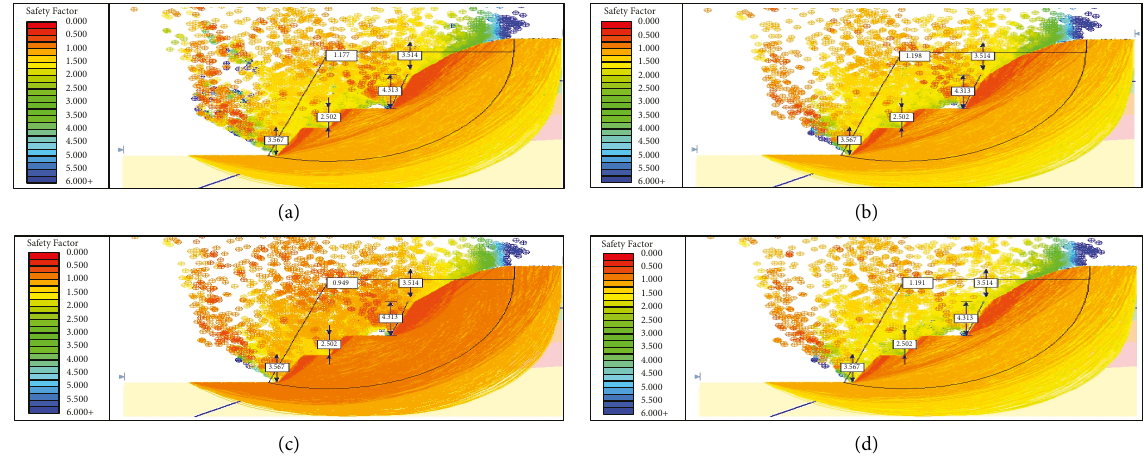
Figure 4: Safety factor simulated for selected slope using (a) Bishop’s simplified method, (b) Janbu’s simplified method, (c) Spencer’s method, and (d) the Corps of Engineers’ Number One method.